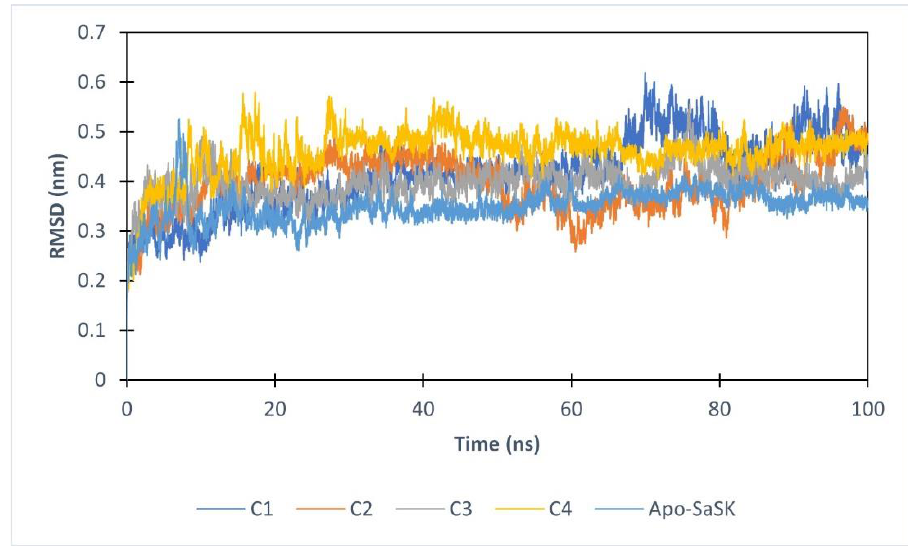
Figure 3. Root mean square deviation analysis for free enzyme and the different protein – ligand complexes.